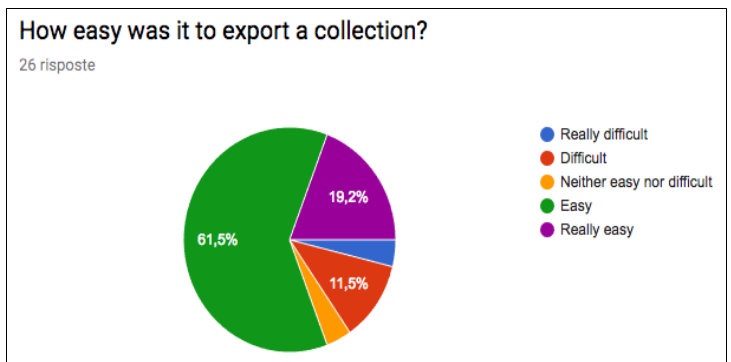
Figure 8. Difficulty of inclusion in a collection